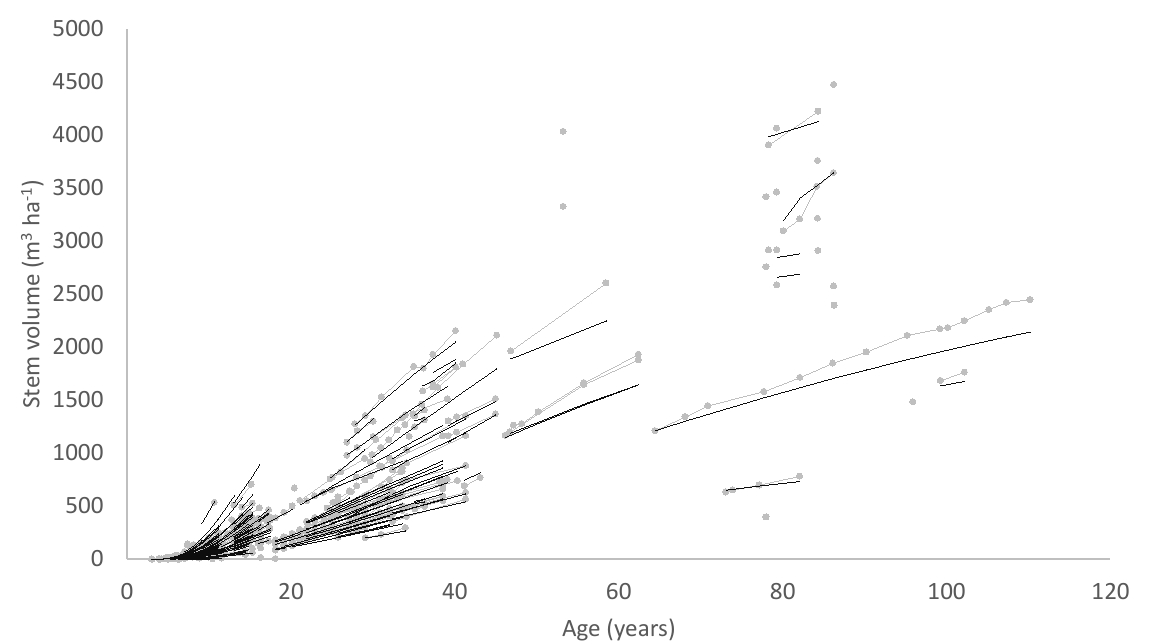
Figure 7. Stem volume vs. age for the plot measurement database. Grey dots indicate measured volumes, with grey solid lines showing plots measured multiple times. Black lines show predictions from the growth model based on the initial measurement in each plot.